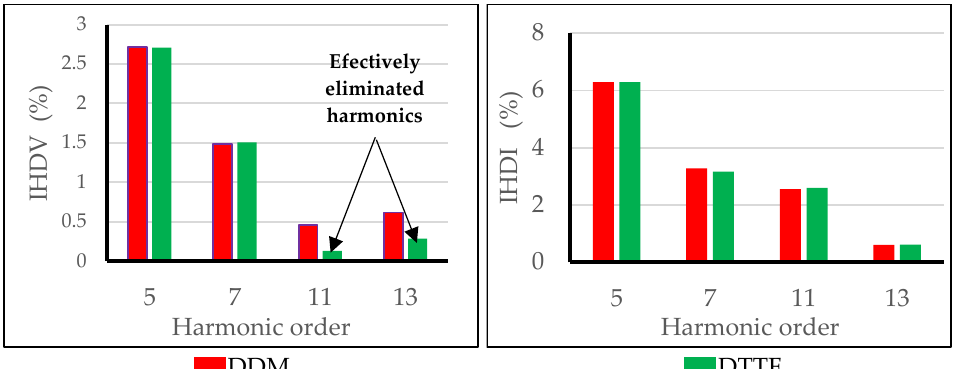
Figure 11. The individual load current harmonics.